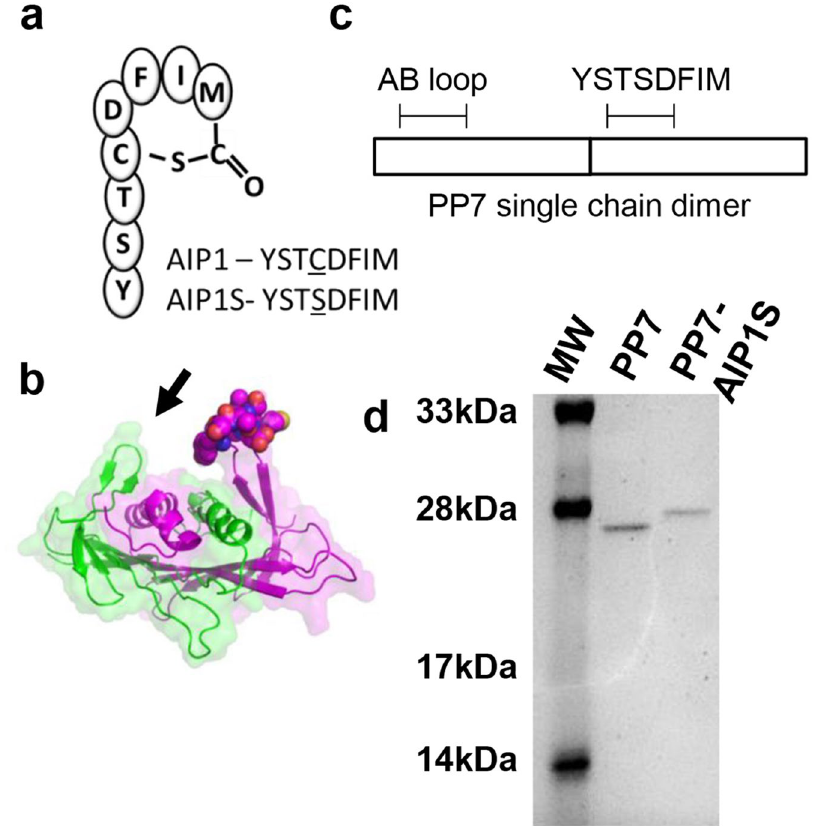
Figure 1. Design and preparation of PP7-AIP1S VLPs. ( a ) Schematic of AIP1 and amino acid sequence of AIP1-C4S (AIP1S). ( b ) Ribbon representation of the PP7 coat protein dimer (one monomer is shown in green and the other in magenta) which can be expressed as a single-chain dimer. Depicted is the first AB loop (indicated by arrow) and the AIP1S sequence (spheres) modeled into the second AB loop (PDB ID 2QUD 21 ) using GalaxyWeb 29, 30 . Image prepared using PyMol (PyMOL molecular graphics system, version 1.5.0.4; Schrodinger, LLC). ( c ) Schematic of the site of AIP1S insertion into the second AB loop of the PP7 single chain dimer. ( d ) Coomassie-stained 16% SDS-PAGE showing the relative size of the PP7 single-chain dimer compared to PP7 with the AIP1S